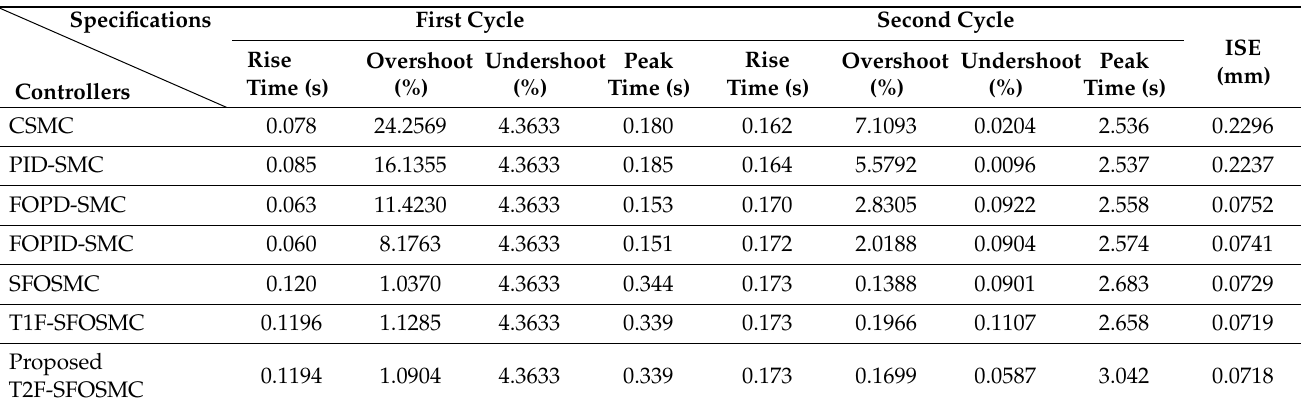
Table 2. Time response parameters of various controllers for the 3DOF surgical manipulator’s Joint1 for 1st and 2nd cycle.